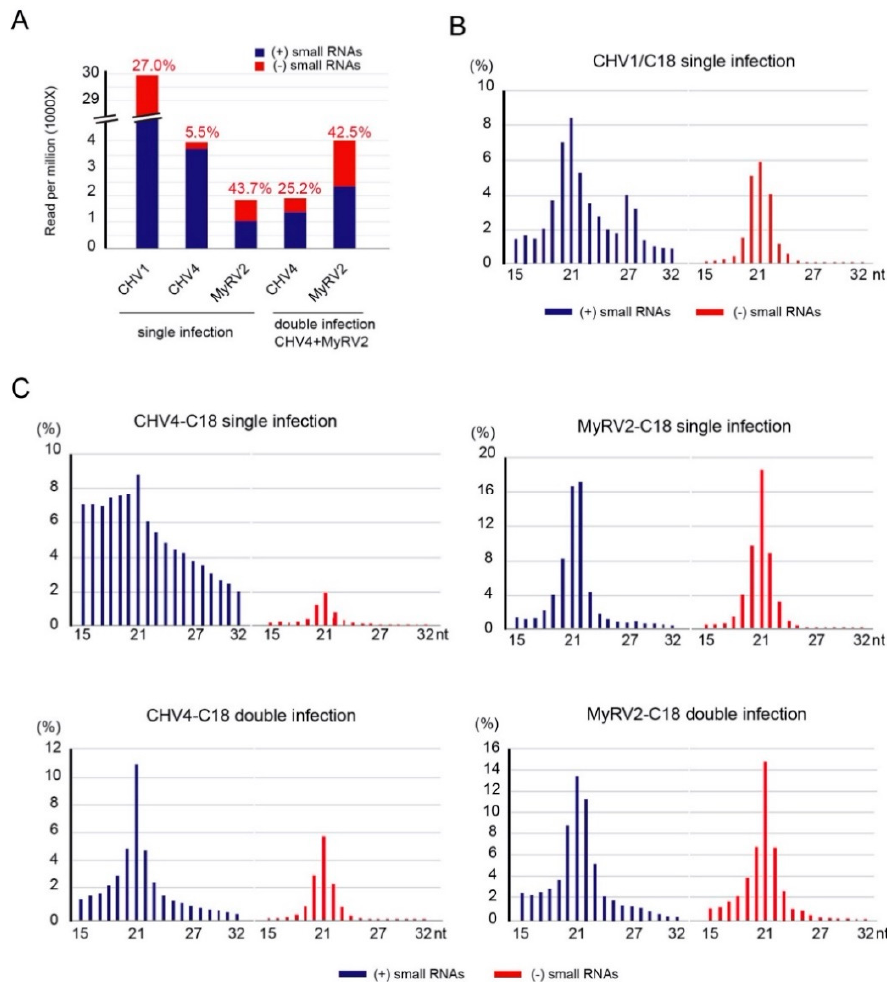
Figure 2. Viral-derived small RNA profiling of C. parasitica C18 strain in either singly or doubly infected by CHV4-C18 and MyRV2. ( A ) Sense and small antisense RNAs (15 to 32 nt) derived from singly or doubly infected CHV4-C18 and MyRV2 are shown on a per-million-total-small-RNA read (the y-axis represents the one-thousandth read numbers). The C18 strain infected singly by CHV1-EP713 (wild type) was also included for the analysis as a reference. The percentage shown on each bar represents the ratio of negative strand small RNAs. ( B ) Size distributions of small RNAs derived from CHV1 in singly infected C18. ( C ) Size distributions of virus-derived small RNAs in single and double infections of strain C18 by CHV4-C18 and/or MyRV2. Blue and red bars denote plus-strand and minus-strand small RNAs ( B , C ).